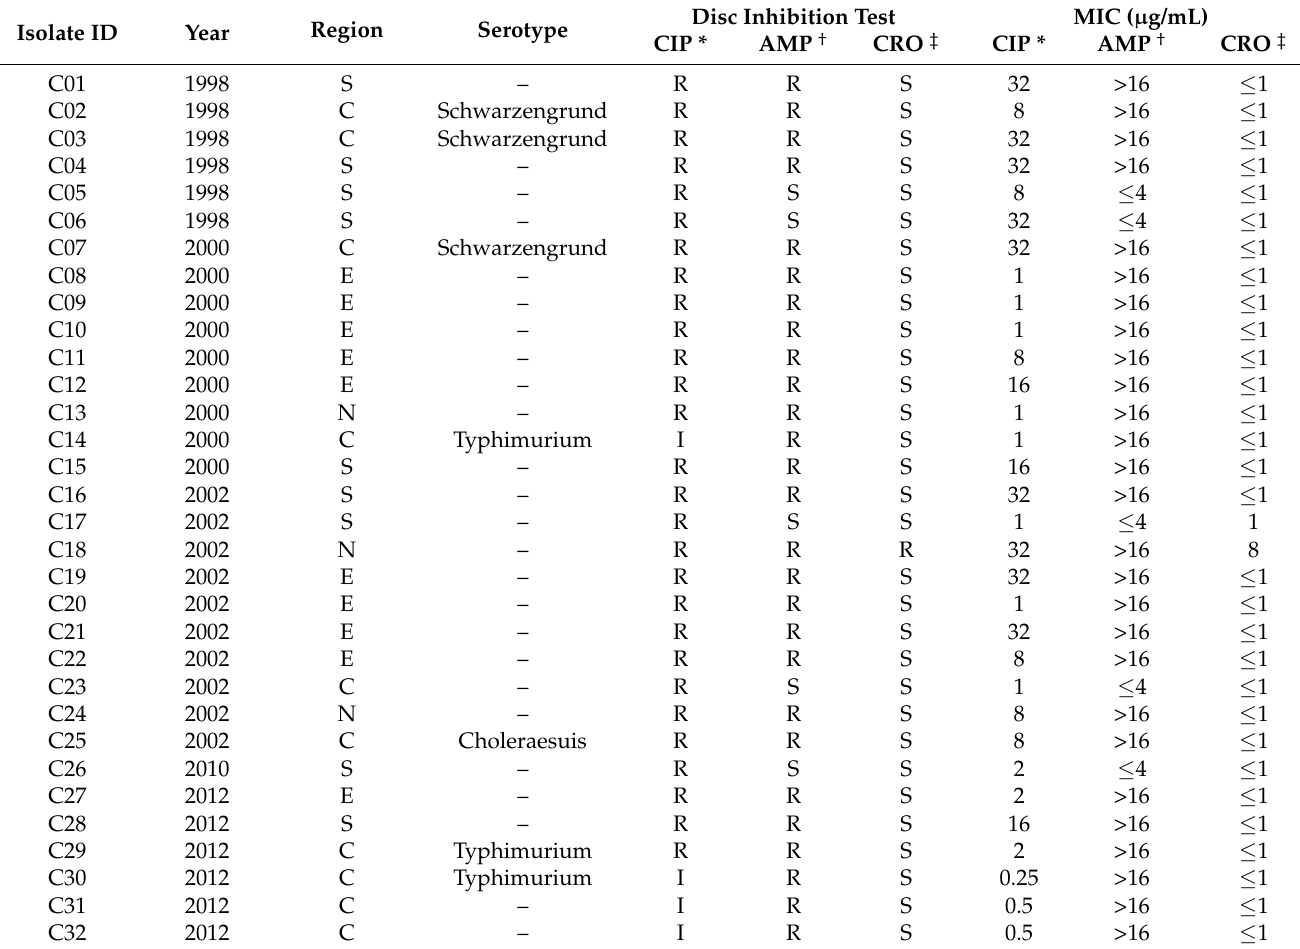
Table 5. The 39 clinical isolates of CIP-nonsusceptible NTS and their antibiotic susceptibility to three antibiotics according to the CLSI guideline